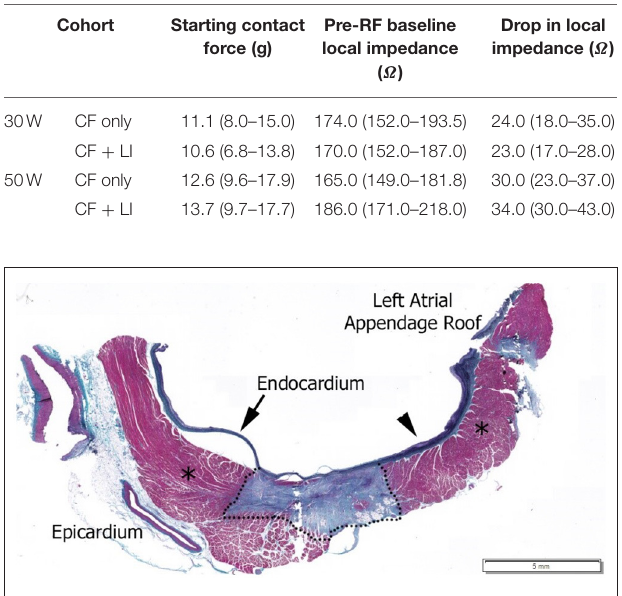
during RF ranged from 23 to 34 Ω depending on the ablation tissue sample from a focal application in the LA is included in Figure 2 . This cross-section, stained with hematoxylin and eosin, is excised from a lesion created with 30 W of RF energy for 9